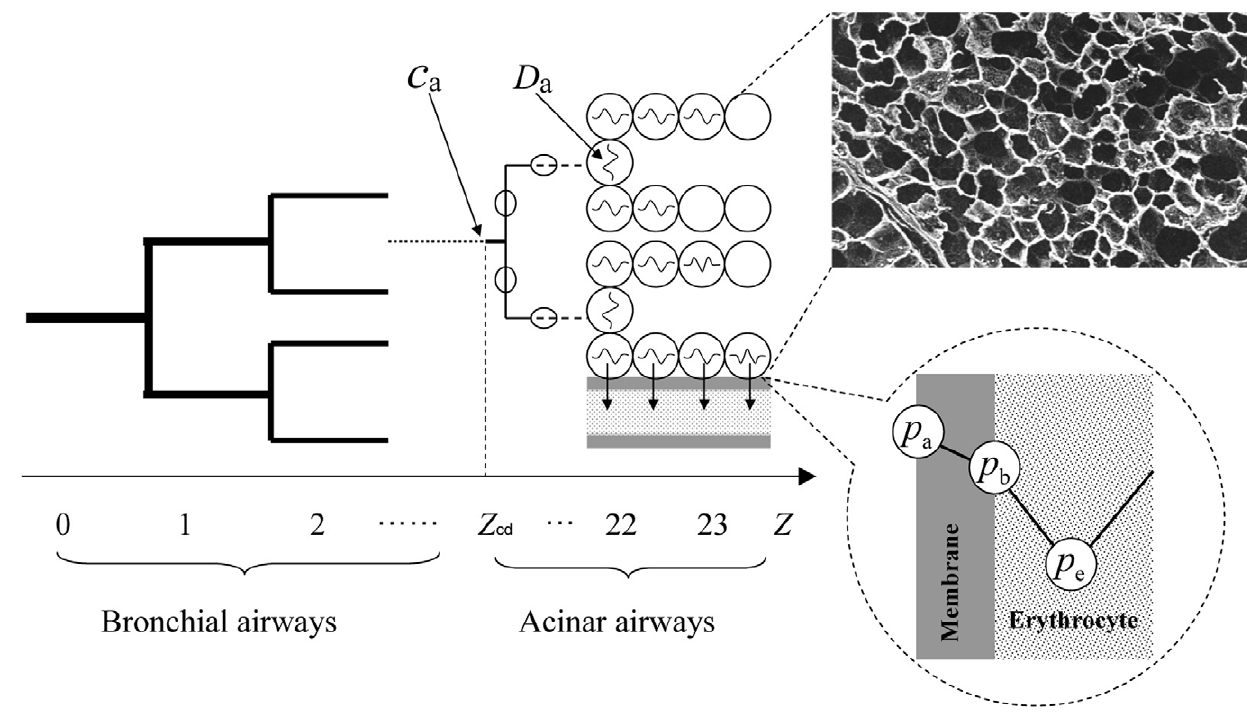
Figure 1. Oxygen transport in the lung, as a function of branching generation z . The transition from convection (heavy lines) to diffusion (light lines) occurs at generation z cd , with z cd ~ 18, 19, 20, 21 at rest, moderate exercise, heavy exercise, and maximum exercise, respectively (Table 2, see Methods section). The bronchial ducts ( z =0–14) do not carry alveoli; the acinar ducts ( z =15–23) are lined with alveoli (circles). In the ducts with z $ z cd , O 2 diffuses through the airways (diffusion coefficient of O 2 in air, D a ), crosses the alveolar membrane (air-erythrocyte barrier including the alveolar tissue and plasma; hatched; permeability W ), and binds to an erythrocyte in the